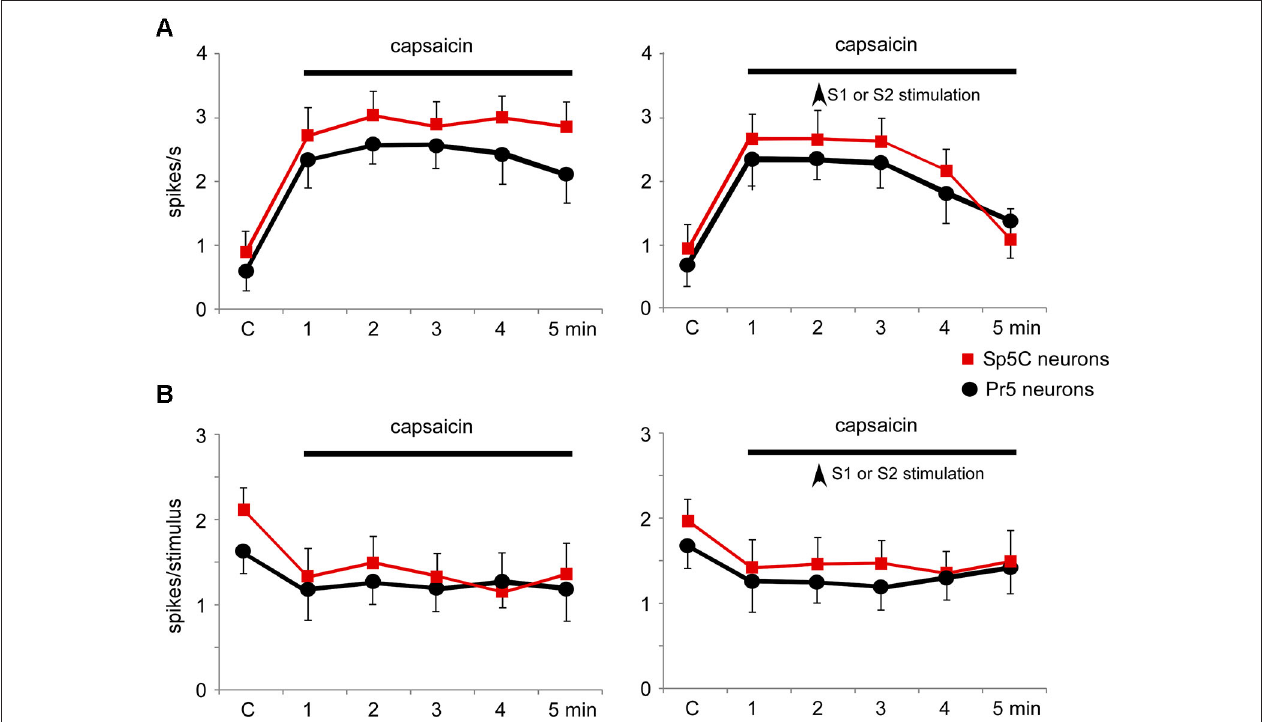
(vertical arrow) inhibited the capsaicin-evoked increase of the firing rate (right plot). (B) Plot of the tactile responses of Pr5 (black circles) and Sp5C (red squares) after application of capsaicin cream on the whisker pad. Tactile responses decreased in both types of neurons. Electrical stimulation (3 trains of stimuli; 50 Hz during 500 ms repeated every 2 s) of S1 or S2 cortex (vertical arrow) did not modify the capsaicin-evoked decrease in tactile